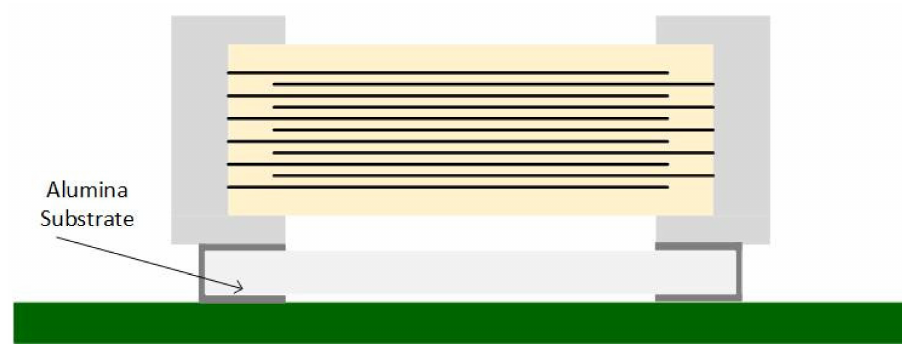
Figure 7. Alumin Substrate Capacitor.